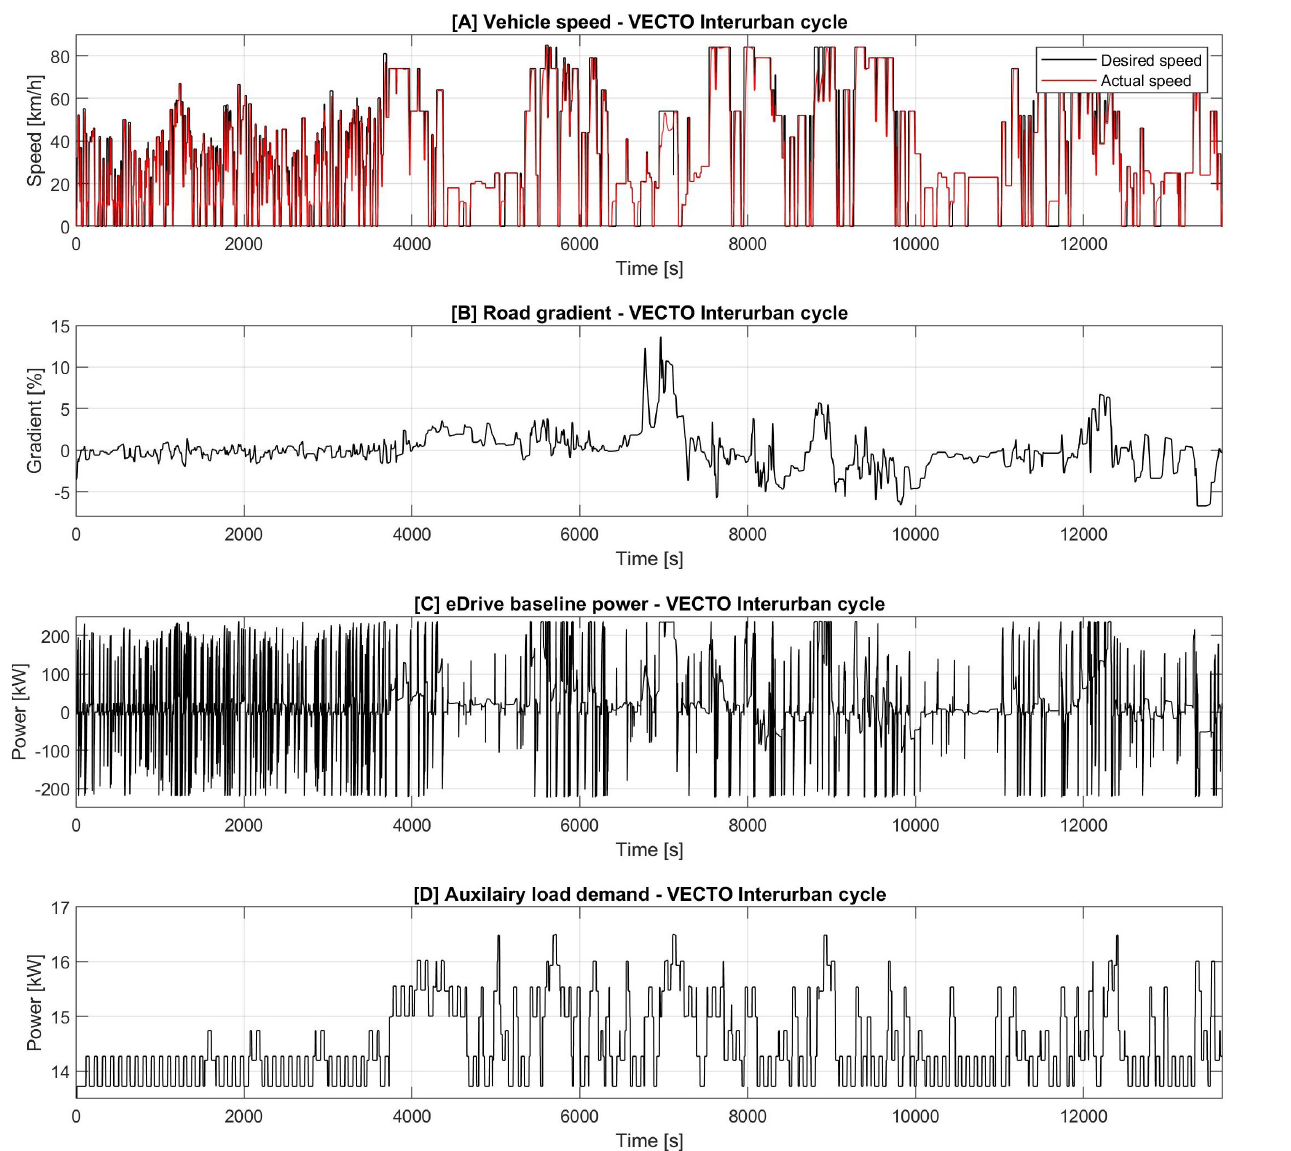
Figure 3. VECTO interurban ( A ) cycle speed recommendation and actual speed from distance- based forward model, ( B ) road gradient, ( C ) eDrive power for baseline configuration (240 kW) and ( D ) auxiliary load including HVAC and